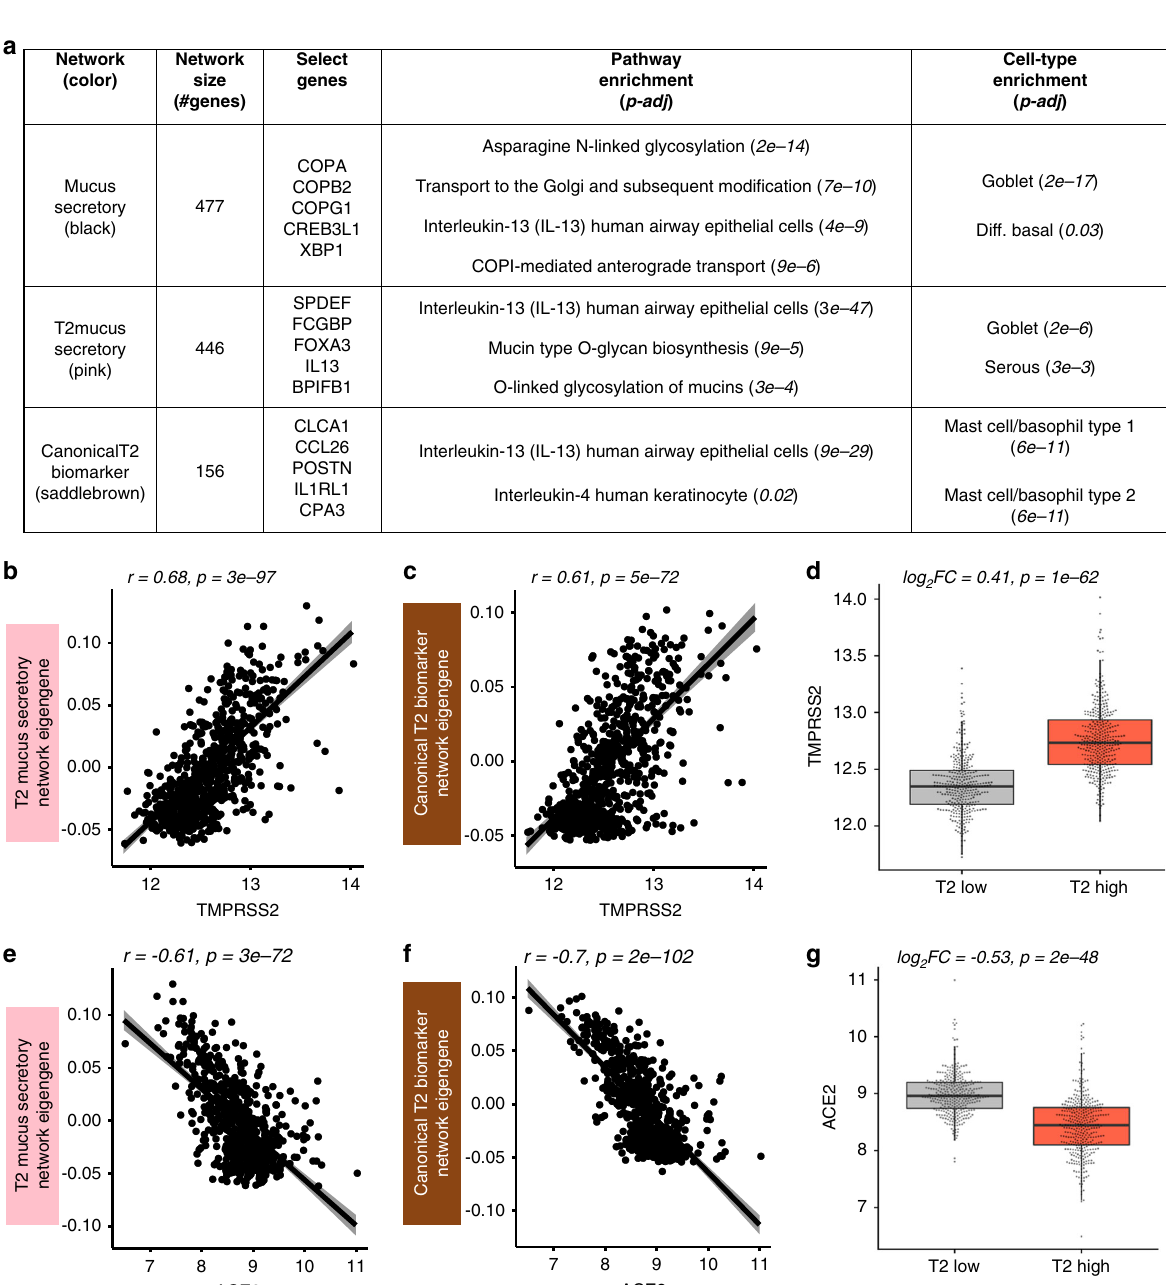
Fig. 2 TMPRSS2 is part of a T2 in fl ammation-induced mucus secretory network. a WGCNA identi fi ed networks of co-regulated genes related to mucus secretory function (black), T2 in fl ammation-induced mucus secretory function (pink), and canonical T2 in fl ammation biomarkers (saddle brown). TMPRSS2 was within the pink network. Select pathway and cell-type enrichments for network genes are shown. Enrichment p -values were obtained from a one-sided hypergeometric test. Benjamini – Hochberg correction was used to control for false discovery rate. b Scatterplot revealing a strong positive correlation between TMPRSS2 expression and summary (eigengene) expression of the T2 in fl ammatory, mucus secretory network. p -values were obtained from the two-sided Pearson correlation test. c Scatterplot revealing a strong positive correlation between TMPRSS2 expression and summary (eigengene) expression of the canonical T2 in fl ammation biomarker network. p -values were obtained from the two-sided Pearson correlation test. d Box plots revealing strong upregulation of TMPRSS2 expression among T2-high ( n = 364) compared to T2-low ( n = 331) subjects. Differential expression testing between T2- high and T2-low groups was performed using a two-sided Wilcoxon test. e Scatterplot revealing a strong negative correlation between ACE2 expression and summary (eigengene) expression of the T2 in fl ammation mucus secretory network. p -values were obtained from the two-sided Pearson correlation test. f Scatterplot revealing a strong negative correlation between ACE2 expression and summary (eigengene) expression of the canonical T2 in fl ammation biomarker network. p -values were obtained from the two-sided Pearson correlation test. g Box plots revealing strong downregulation of ACE2 expression among T2-high ( n = 364) compared to T2-low ( n = 331) subjects. Differential expression testing between T2-high and T2-low groups was performed using a two-sided Wilcoxon test. Box centers give the median, upper and lower box bounds correspond to fi rst and third quartiles and the upper/lower whiskers extend from the upper/lower bounds up to/down from the largest/smallest value, no further than 1.5 × IQR from the upper/lower bound (where IQR is the inter-quartile range). Data beyond the end of whiskers are plotted